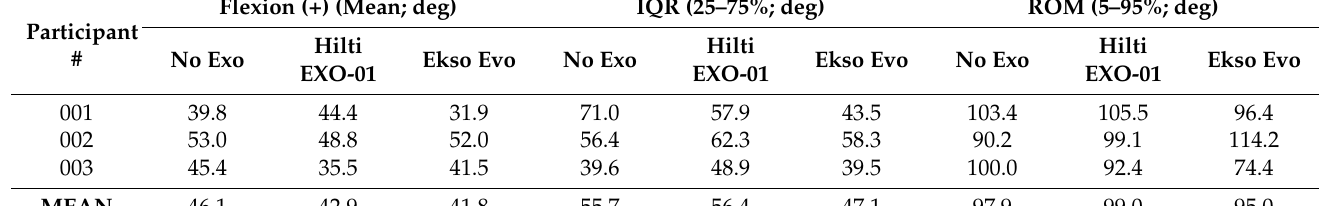
Table 7. Flexion/extension (deg) of the left shoulder.